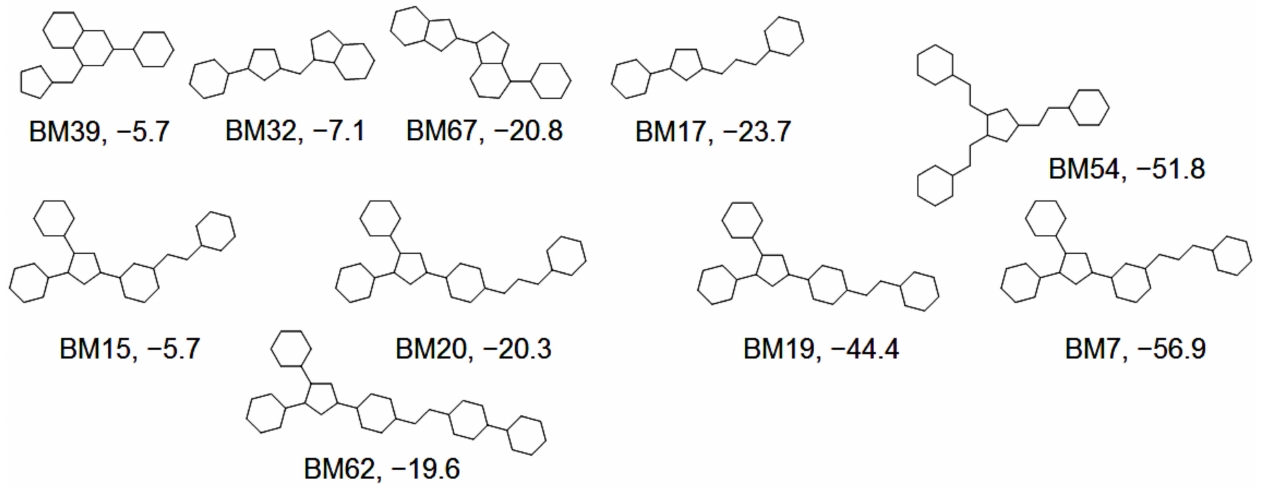
Figure 7. The BM skeletons associated with the lowest averages of the compounds’ SP